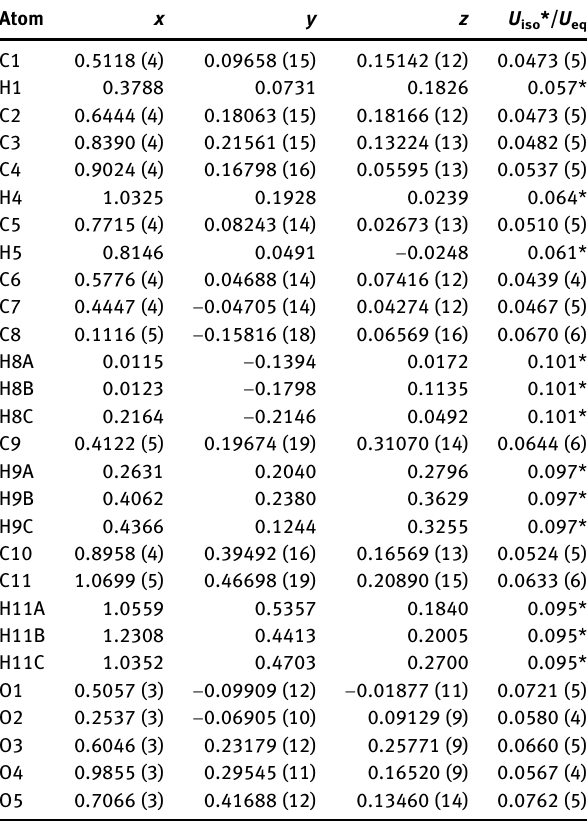
Table  : Fractional atomic coordinates and isotropic or equivalent isotropic displacement parameters (Å 